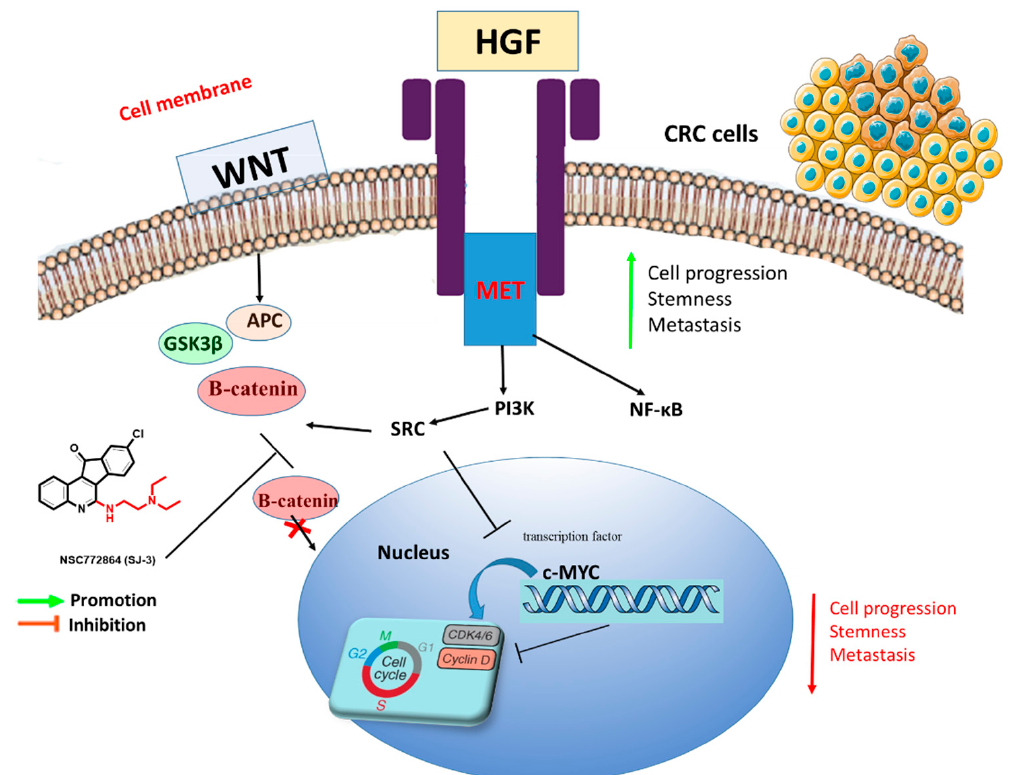
Figure 16. Schematic diagram shows NSC772864 may directly target Met receptor-mediated cell cycle progression through WNT/ β -catenin/GSK3 β pathway and MYC transcription factor. c-Met expression enhances the Wnt/ β -catenin signaling and impedes GSK3 β from phosphorylating β - catenin in CRC; this subsequently promotes β -catenin translocation into the nucleus leading to cancer initiation; moreover, proto-oncogene, c-MYC, is associated with the regulation of CCND1, a key regulatory protein through the G1 to S phases of the cell cycle via binding to cyclin-dependent kinase 4 (CDK4) and CDK6 cell cycle, and play crucial roles in cell cycle progression. Therefore, blockade of c-Met/cMYC/CCND1 inhibits CRC cell progression, stemness, and metastasis.